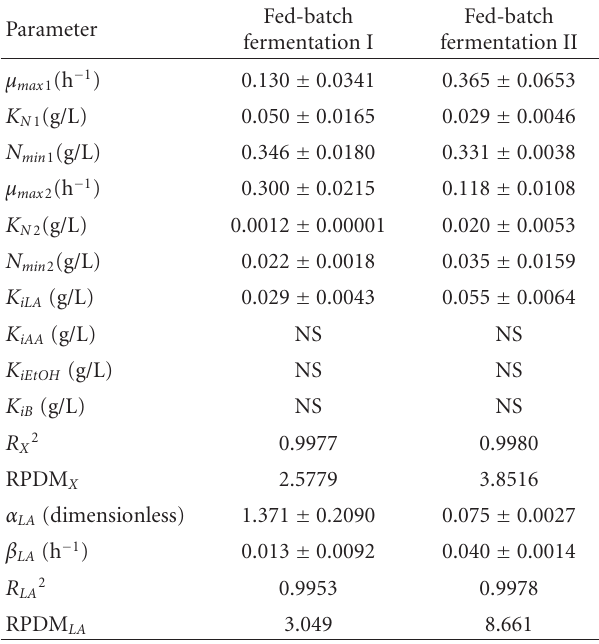
Table 4: Parameter values (means ± SD) of the models (A.6) and (A.7) used for predicting the biphasic growth of Ent. faecium CECT 410 and lactic acid production in the two realkalized fed-batch